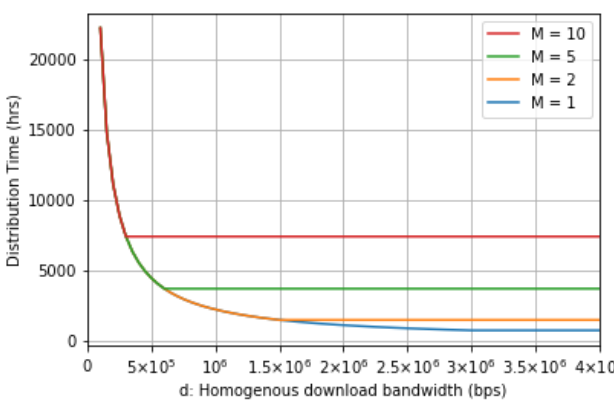
Figure 10. Distribution time while d is varied for some value of